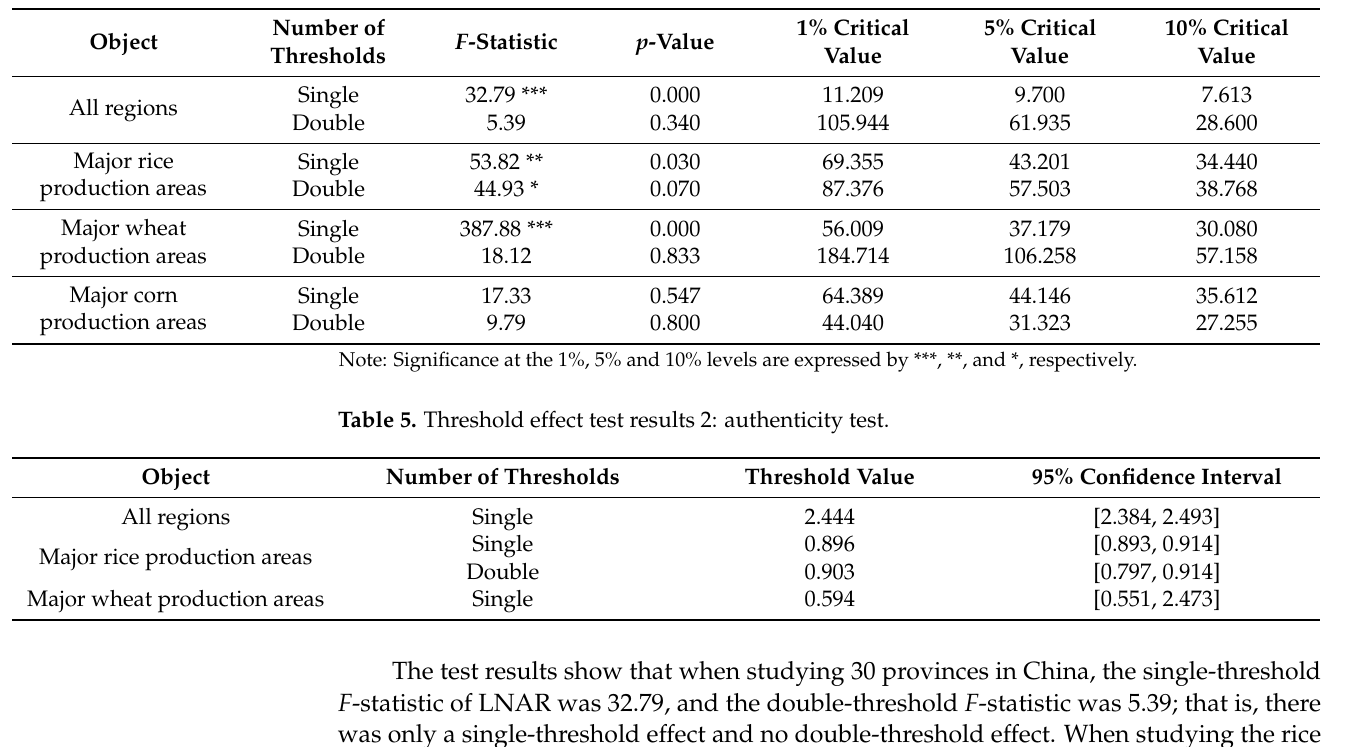
Table 4. Threshold effect test results 1: existence test results.